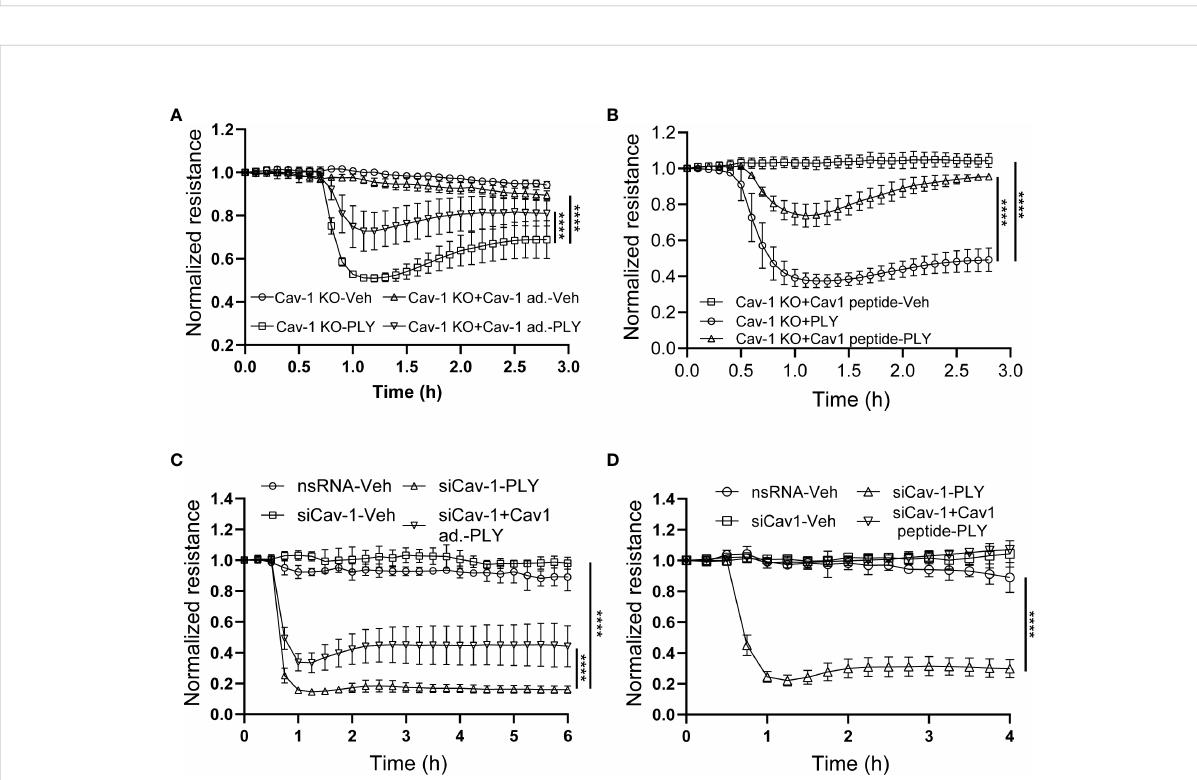
FIGURE 6 Reconstitution of Cav-1 or its scaffolding domain signaling attenuates PLY-induced endothelial barrier disruption. (A) Caveolin-1 overexpression in Cav-1 knock-out HULEC5 a cells ameliorates PLY induced endothelial barrier dysfunction. Cav-1 knock-out endothelial cells were transduced with RFP or Cav-1 adenovirus (10 MOI). After 48 hours the cells were treated with either vehicle or PLY (60ng/mL) and barrier function assessed by changes in TER. (B) Caveolin-1 scaffolding domain peptide ameliorates PLY induced endothelial barrier dysfunction. Cav-1 knockout HULEC5 a were administered the Cav-1 scaffolding domain peptide (10 µM) or vehicle (DMSO). After 24 hours, cells were treated with vehicle (Veh.) or PLY (60 ng/mL) and TER was measured. (C) HLMVECs were transfected with non-speci fi c or Cav-1 speci fi c silencing RNA and rescue experiments were performed by transducing Cav-1 silenced cells with RFP or Cav-1 adenovirus. After 24 hours HLMVECs were treated with vehicle (Veh) or PLY (60 ng/mL) and TER was measured. (D) HLMVECs were transfected with non-speci fi c or Cav-1 speci fi c silencing RNA and rescue experiments were performed by treating the cells with Cav-1 scaffolding peptide (10 µM) or DMSO for 24 hours, followed by PLY (60 ng/mL). Endothelial barrier function was assessed by changes in TER (n=3). ****P<0.0001, two-way ANOVA (with Tukey ’ s multiple comparisons